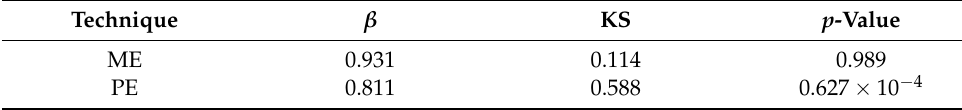
Table 8. Different estimators for EC